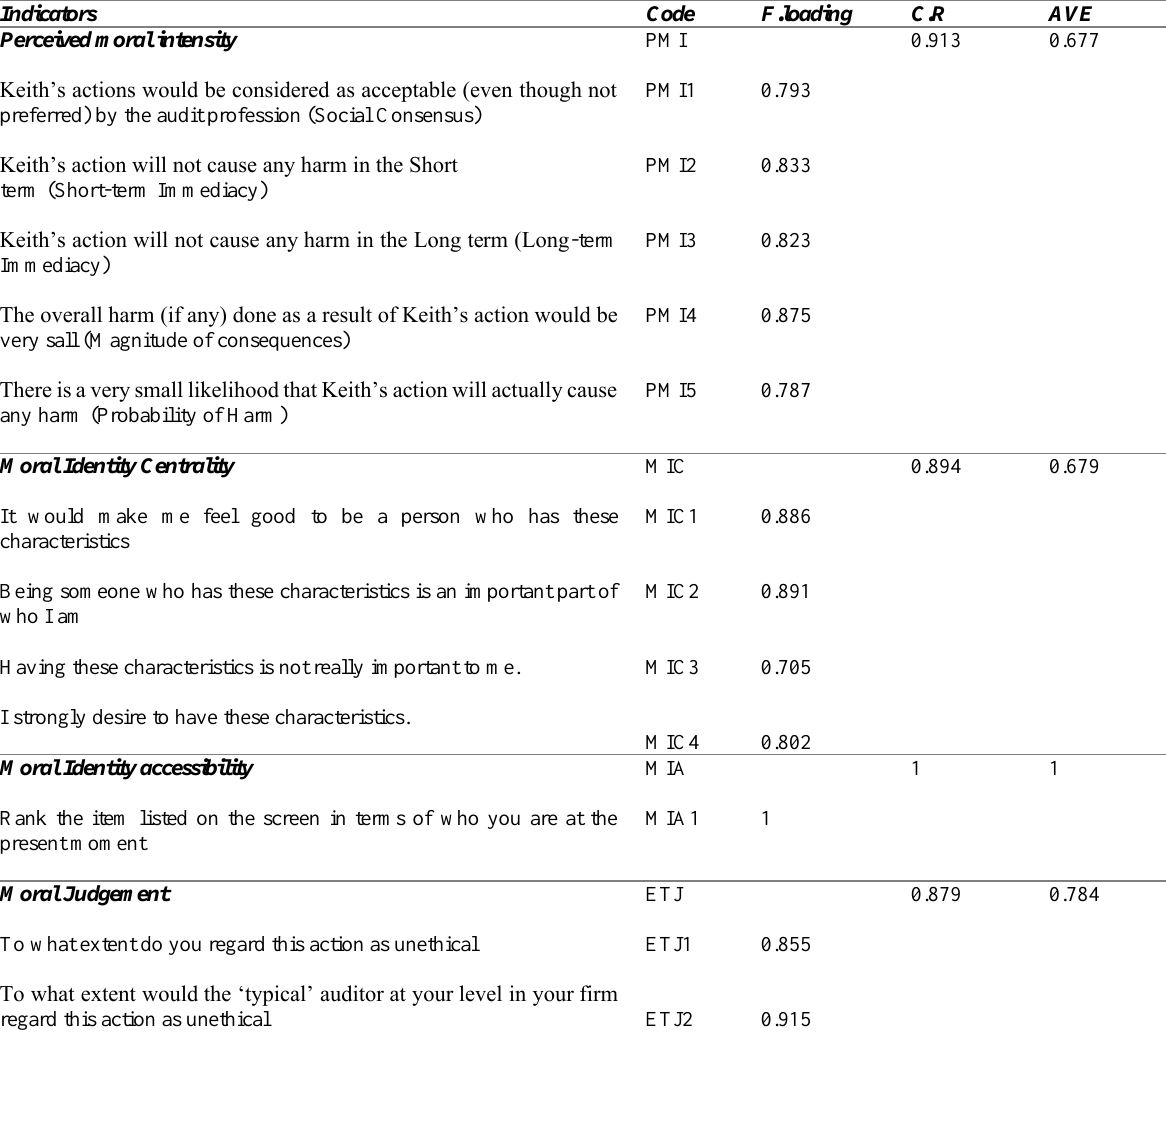
Table 2 : Measurement model: loadings, construct reliability and convergent validity Indicators Code F.loading C.R